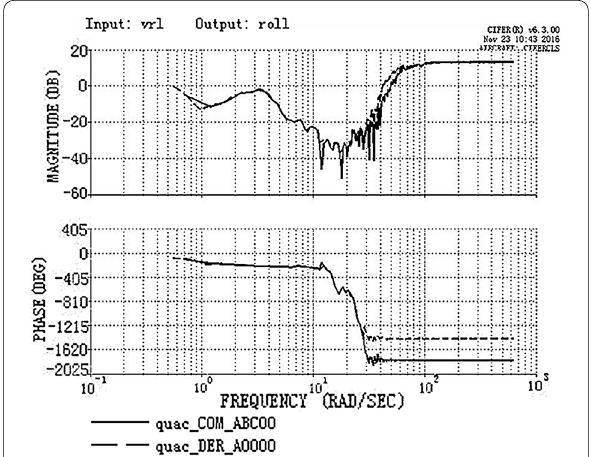
Figure 5 Comparison of the recognition results and experimental data for the frequency